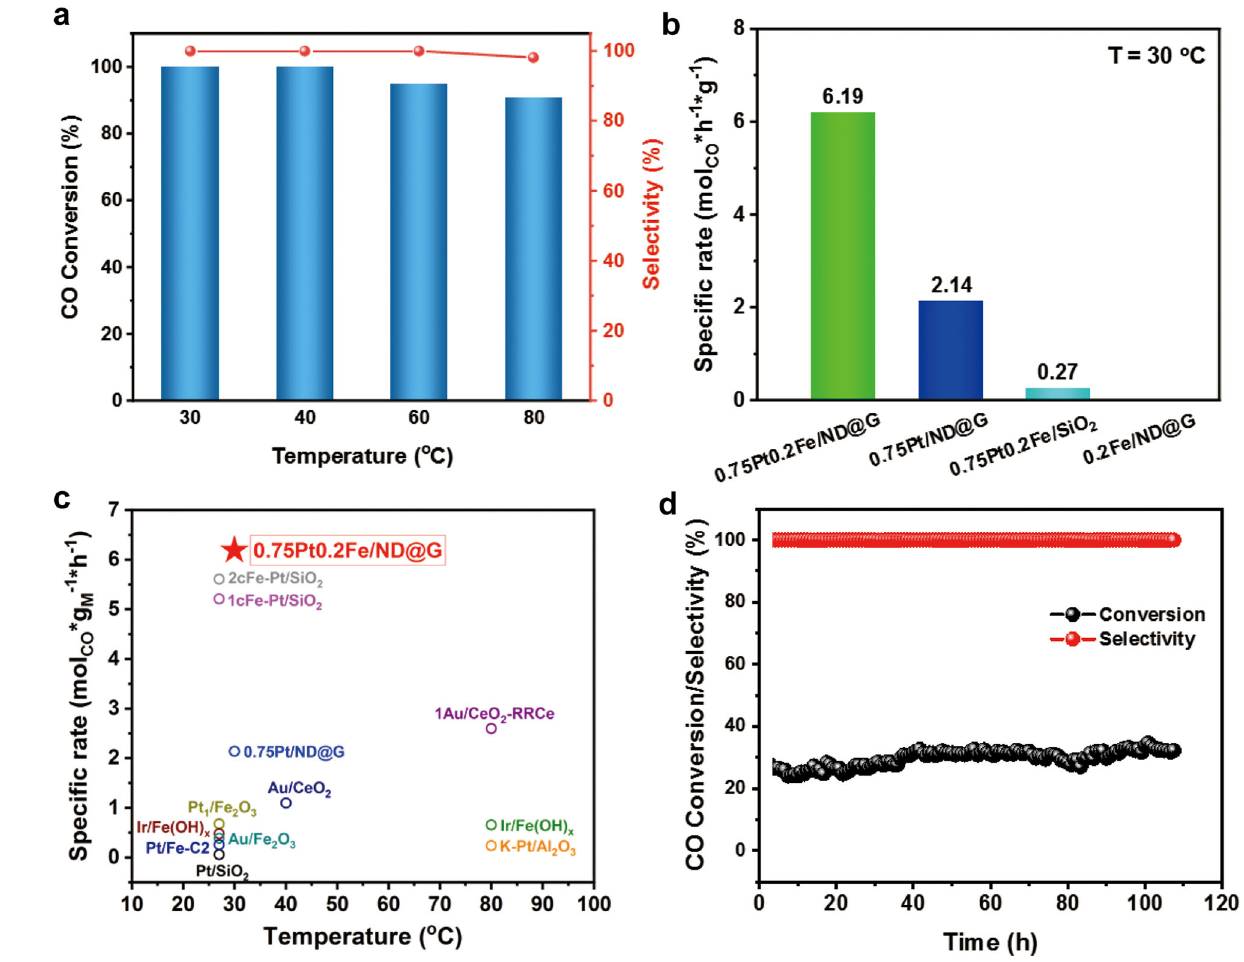
Fig. 3 | Catalytic performance for the PROX reaction. a CO conversion and selectivity of 0.75Pt0.2Fe/ND@G catalyst in PROX reaction. Reaction condi- tions: 1% CO, 0.5% O 2 and 48% H 2 balanced in He; the space velocity is 45000mLg − 1 h − 1 . b Mass speci fi c rates of various PtFe catalysts at 30°C in PROX